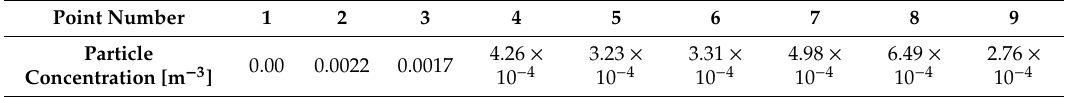
Table 2. Particle concentration in the reference points of simulation 10-135-5.